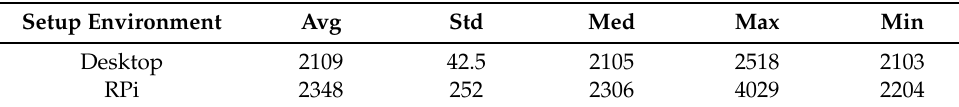
Table 1. Statistics analysis of SET ChainCode latency.